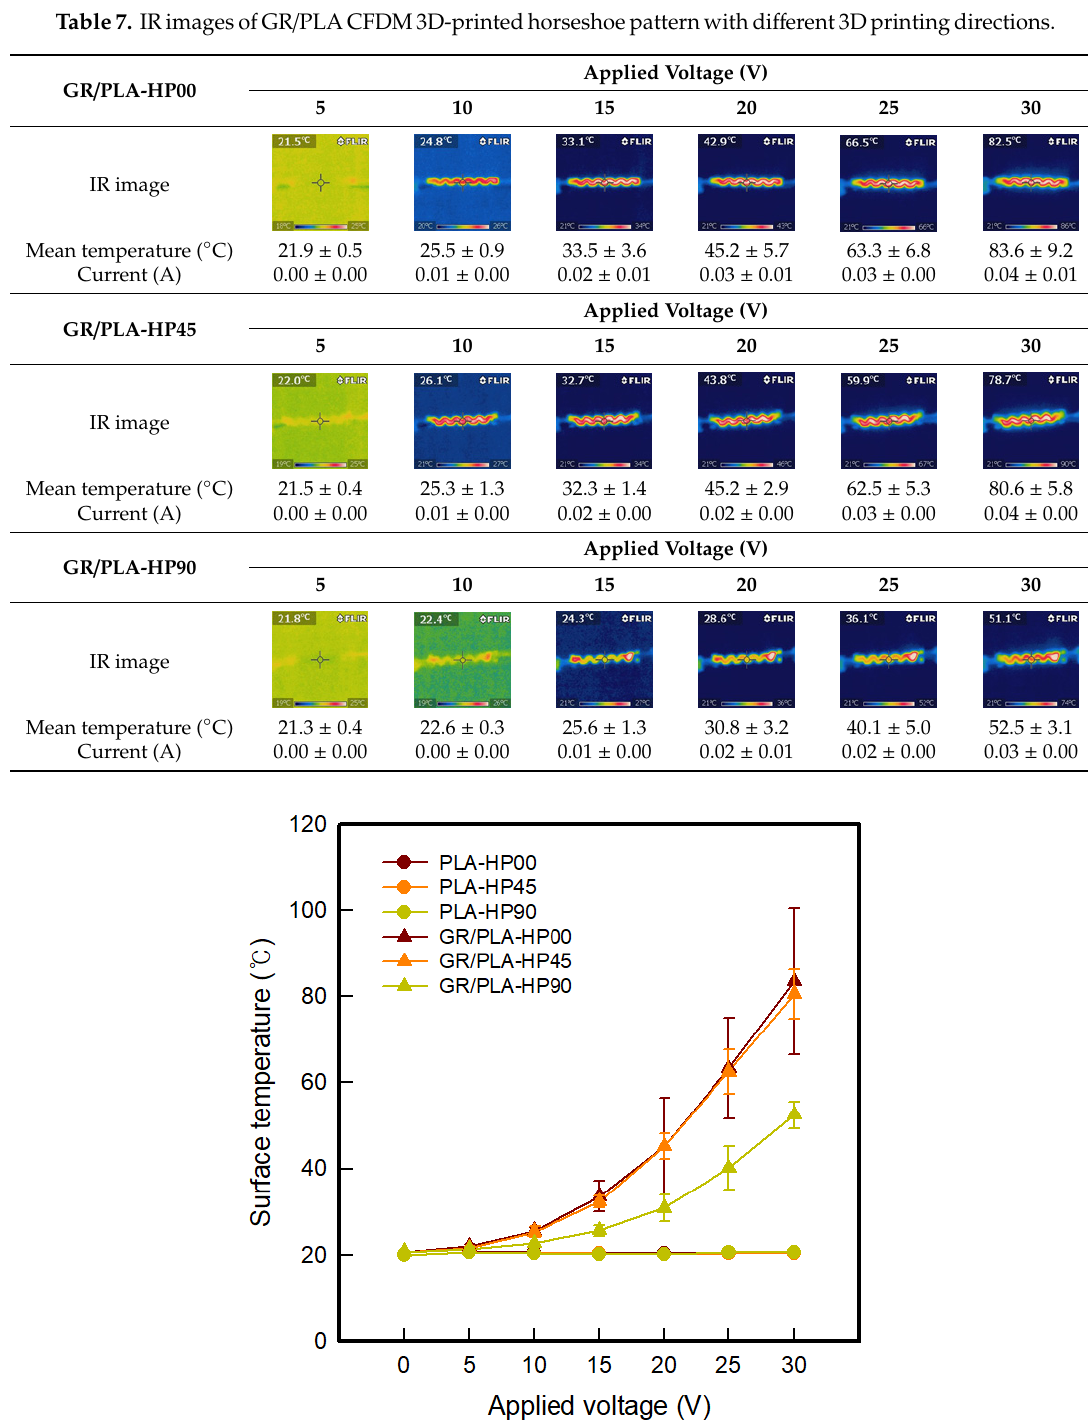
Figure 5. Surface temperatures of CFDM 3D-printed horseshoe pattern with different 3D printing directions.